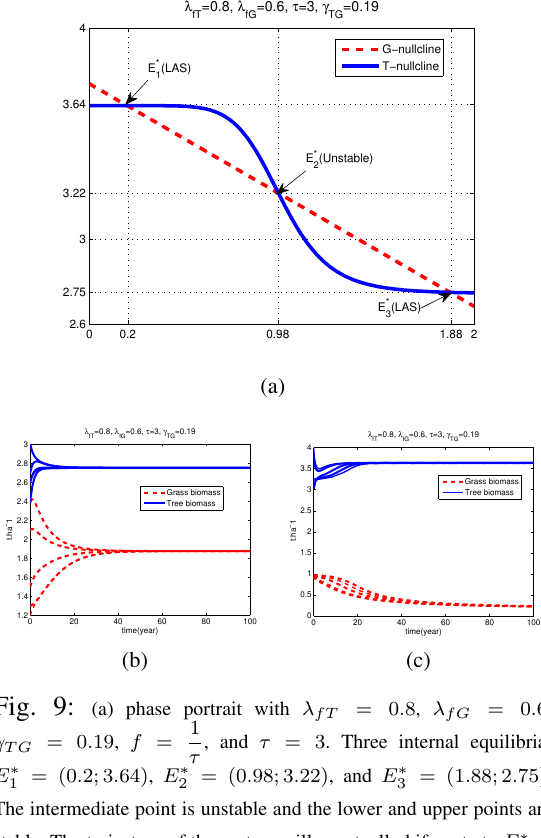
Fig. 9: (a) phase portrait with λ fT = 0 . 8 , λ fG = 0 . 6 , 1 γ TG = 0 . 19 , f = , and τ = 3 . Three internal equilibria: τ E ∗ = (0 . 2;3 . 64) , E ∗ = (0 . 98;3 . 22) , and E ∗ = (1 . 88;2 . 75) . 1 2 3 The intermediate point is unstable and the lower and upper points are stable. The trajectory of the system will eventually bifurcate to E ∗ 1 or E ∗ 3 depending on its initial condition. (b) and (c) show respectively the local stability of E ∗ 1 and E ∗ 3